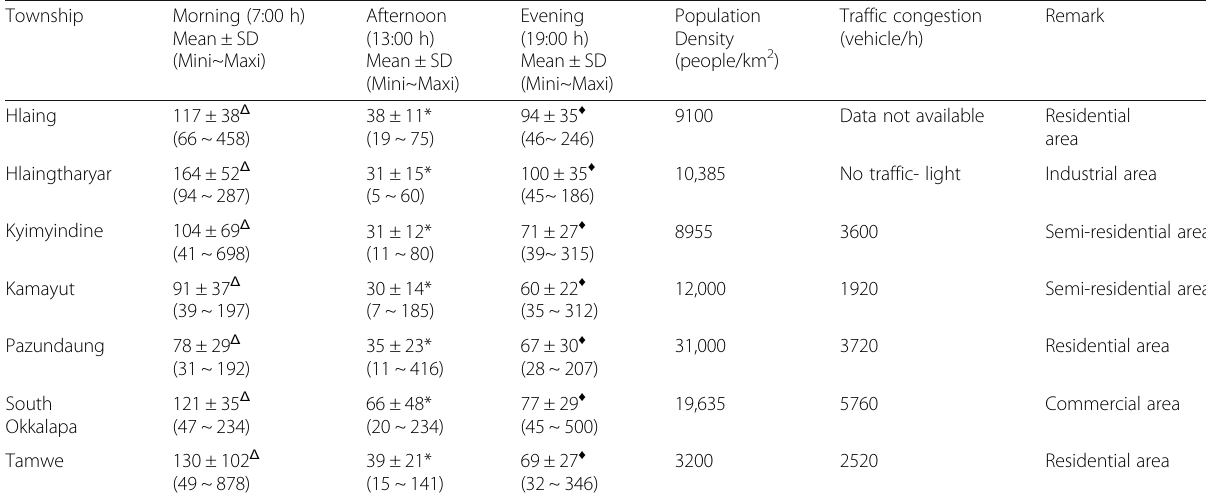
Table 2 PM 2.5 concentrations ( μ g/m 3 ) of seven townships Township